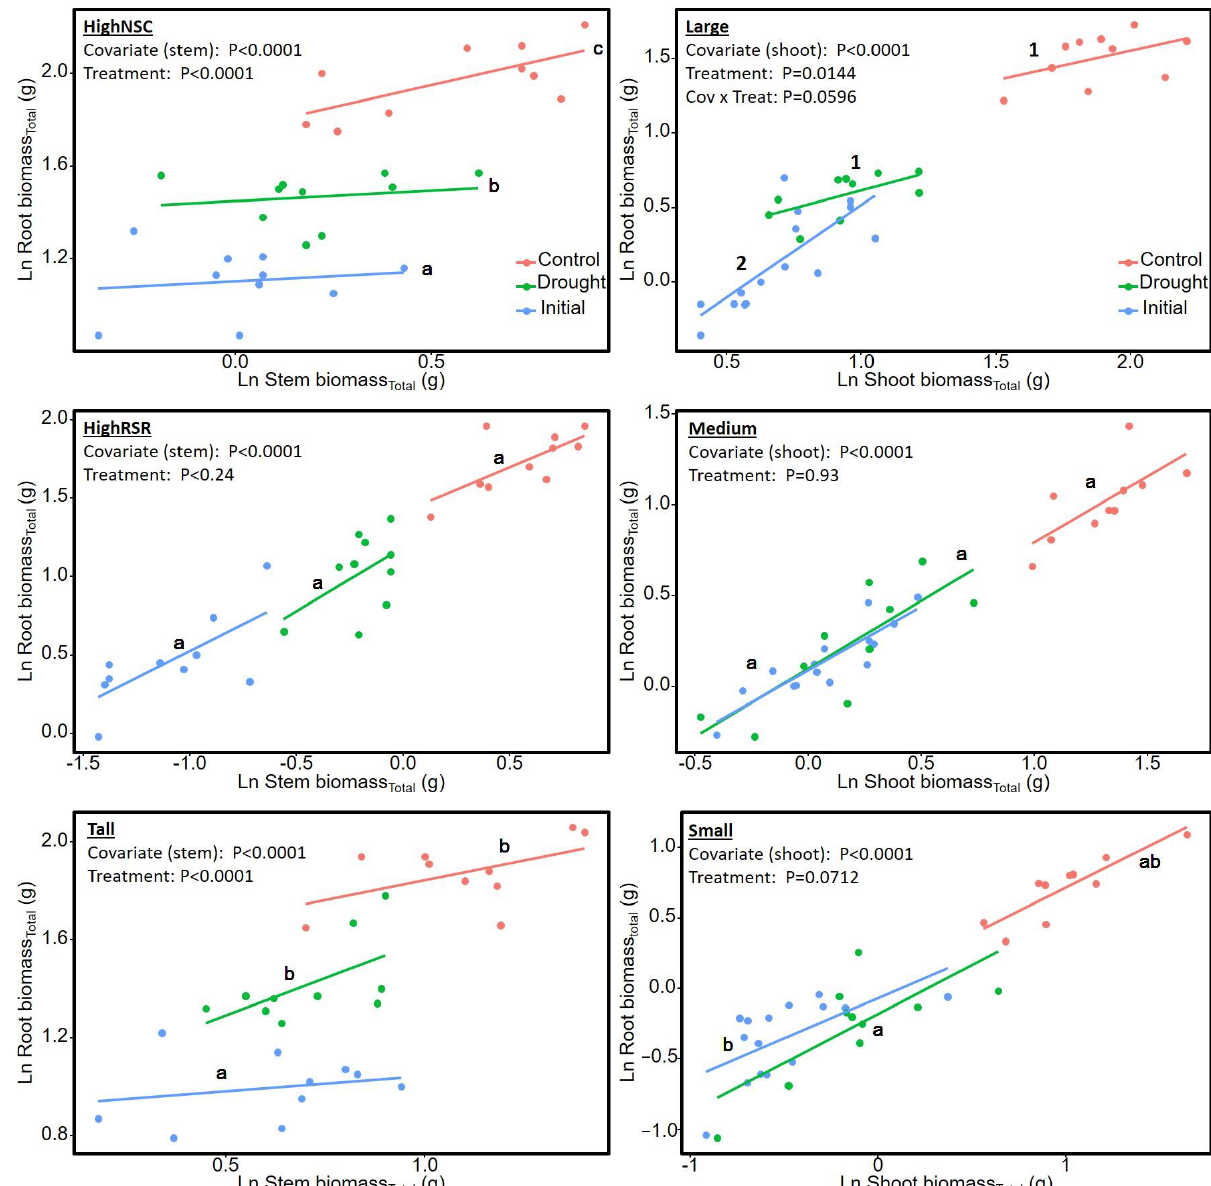
Figure 4. Allometric relationships between root and stem (excl. leaves) Biomass Total (aspen, LEFT column) and root and shoot (incl. needles) Biomass Total (pine, RIGHT column) for three different seedling types at the initial harvest, after well-watered (control) and dry (drought) conditions. Relationships between root and stem biomass in aspen are shown, as seedlings at the initial harvest were leafless. Lines represent individual linear regressions for each treatment and seedling type combination. Significant treatment or covariate × treatment effects indicate differences in biomass allocation between drought, control and initial seedlings. Different letters represent significant differences in intercepts according to Tukey’s HSD ( p < 0.10). For Large pine, there was a significant covariate × treatment interaction; different numbers therefore represent significant differences in slope according to 95% confidence